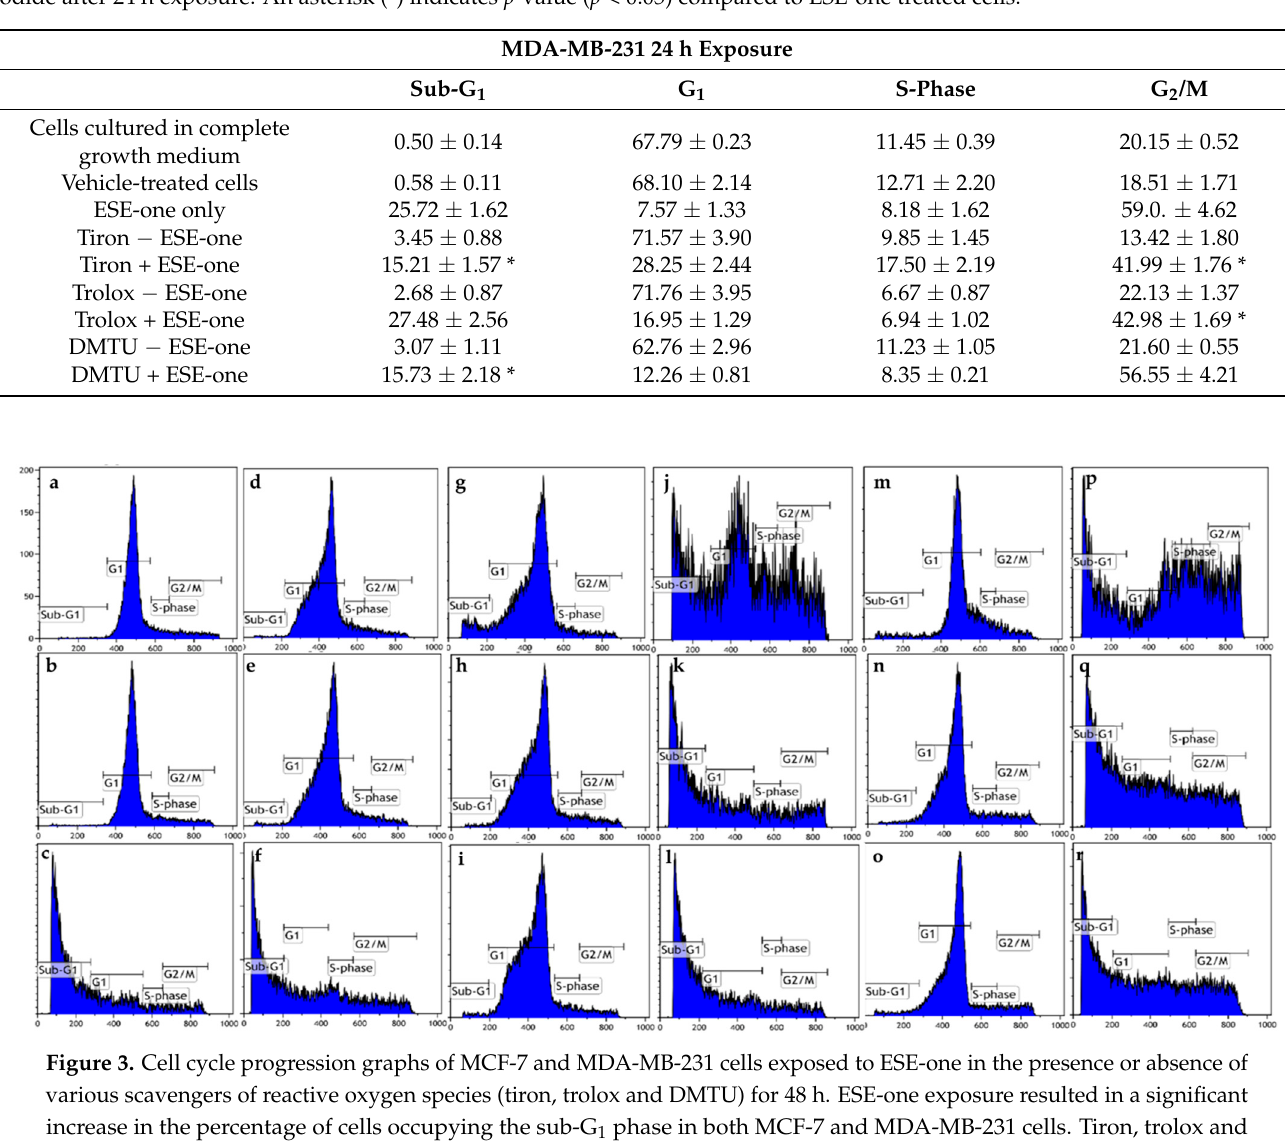
Table 2. Percentage of MDA-MB-231 cells occupying each cell cycle phase as determined by means of flow cytometry using propidium iodide after 24 h exposure. An asterisk (*) indicates p -value ( p < 0.05) compared to ESE-one treated cells.